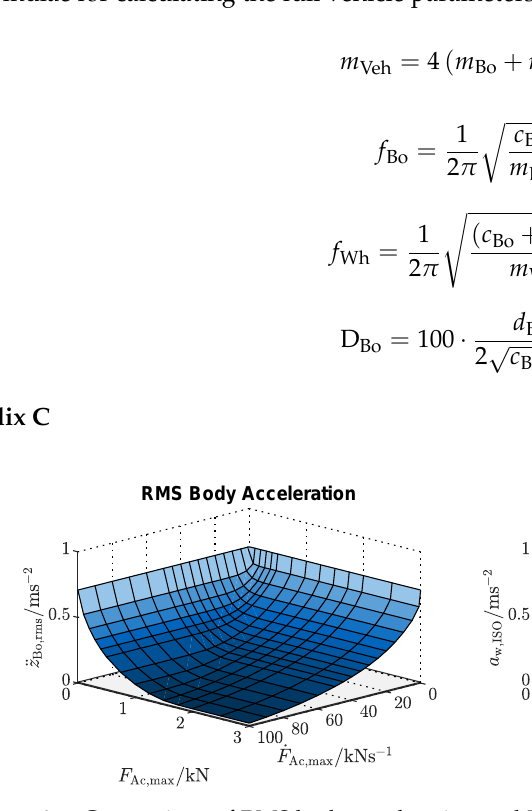
Figure A1. Comparison of RMS body acceleration and ISO-2631 comfort value (weighted RMS) at 90kmh − 1 on the AB profile.